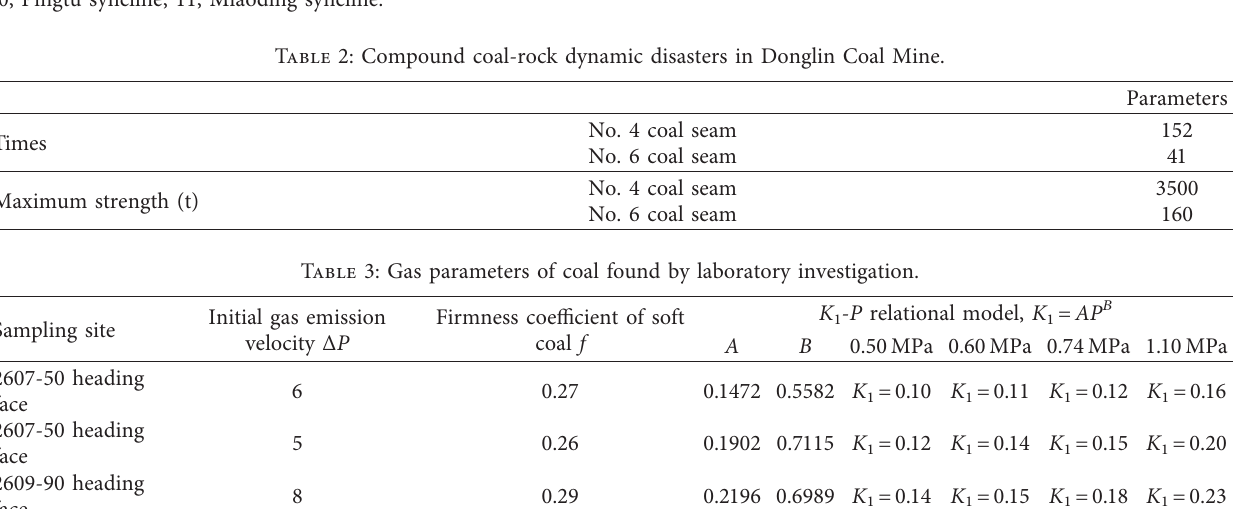
Table 4: Prediction cycle cuttings desorption index K